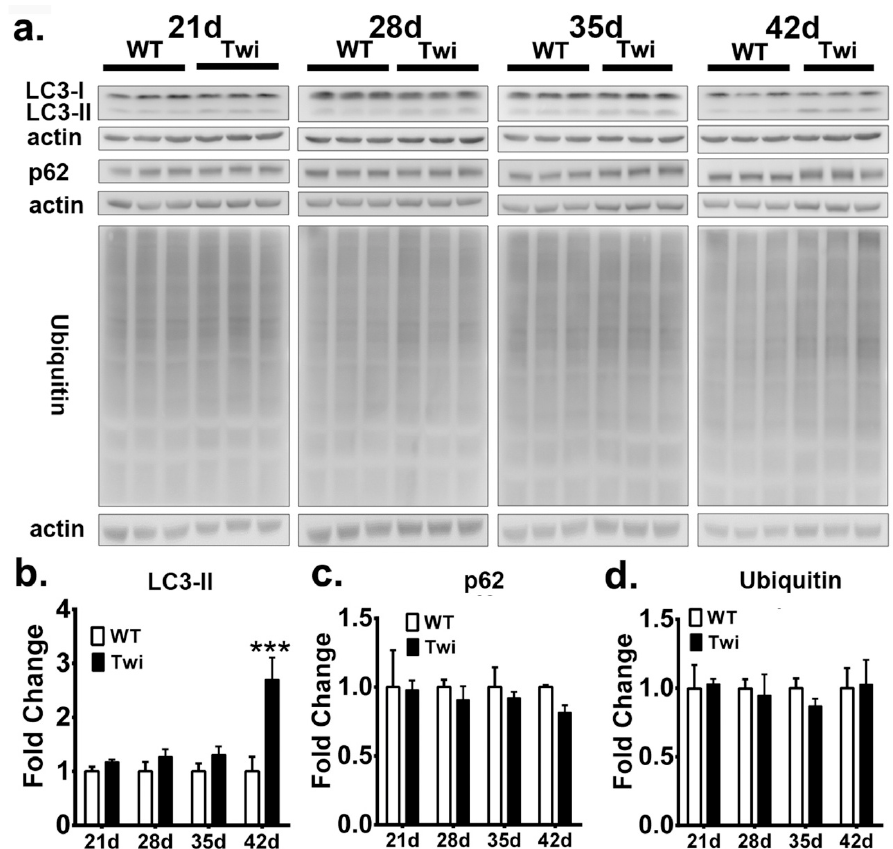
Figure 4. Increased autophagic flux in twitcher brain. a Western blot analysis of the total LC3-II, p62, and ubiquitin content in brain stems from wild-type (WT) and twitcher (Twi) mice at ages 21 days, 28 days, 35 days, and 42 days. Soluble fraction was analyzed and β -actin (actin) was used for the loading control. b , c , d Quantification of soluble LC3-II ( b ), p62 ( c ), and ubiquitin ( d ). Values are expressed as mean ± S.D. ( n = 3). Statistical significance *** p < 0.001.